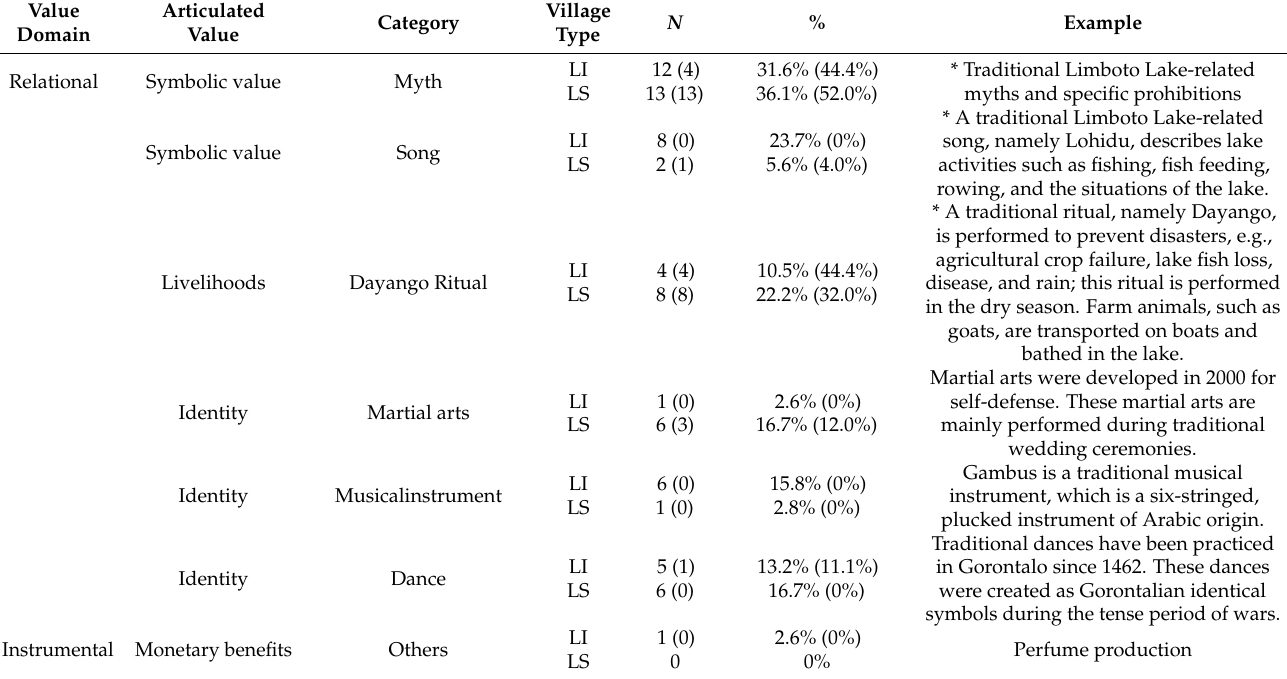
Table 2. Examples of the cultural